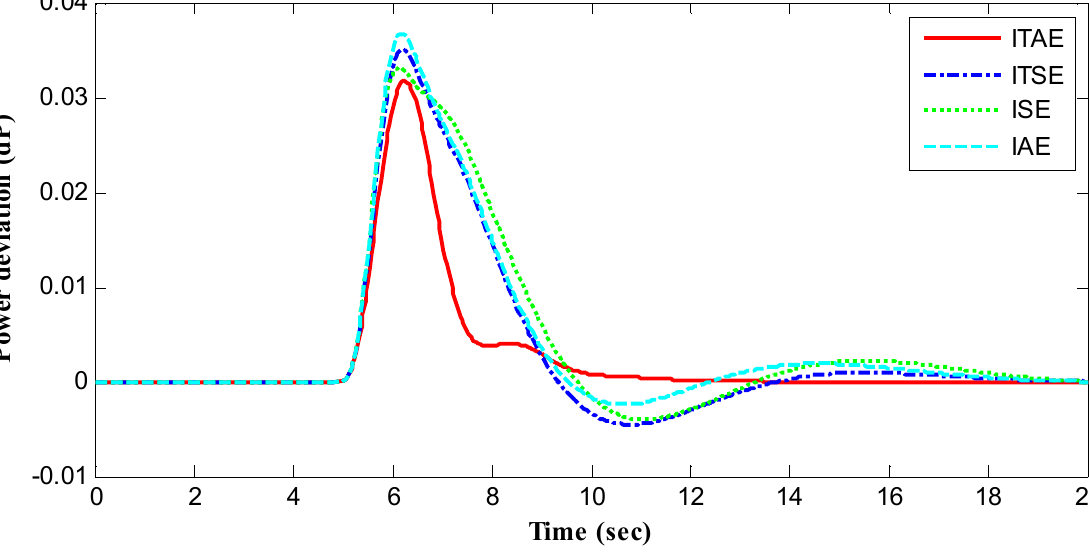
Figure 14. Power deviation ∆ P using performance indices used in the literature. The parameters of the 2DOF-PID control scheme optimized conventionally, using the DA via the ITAE, using the DA via the proposed IB-WGFF are indicated in Table 7. In addition, the dynamic responses of the frequency deviations for the two-areas (i.e., ∆ f 2 and ∆ f 2 ) and the tie-line power deviation ( ∆ P ) for the conventional 2DOF-PID, the DA- 2DOF-PID using the ITAE, and the DA-2-DOF-PID controller via the proposed IB-WGFF (for C 1 = 0.5 and C 2 = 0.5) are shown in Figures